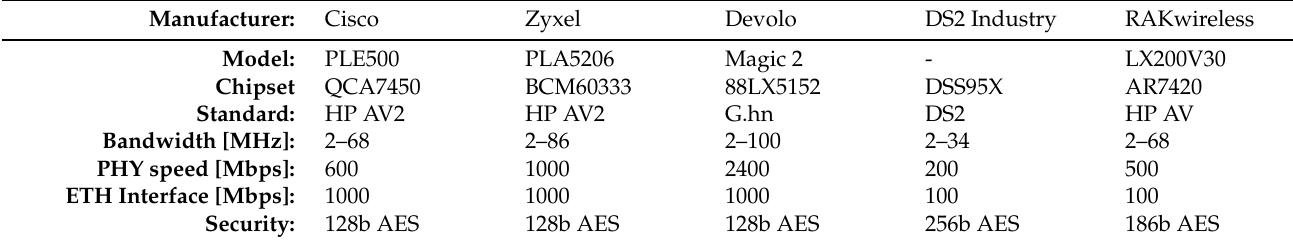
Table 4. Tested broadband PLC